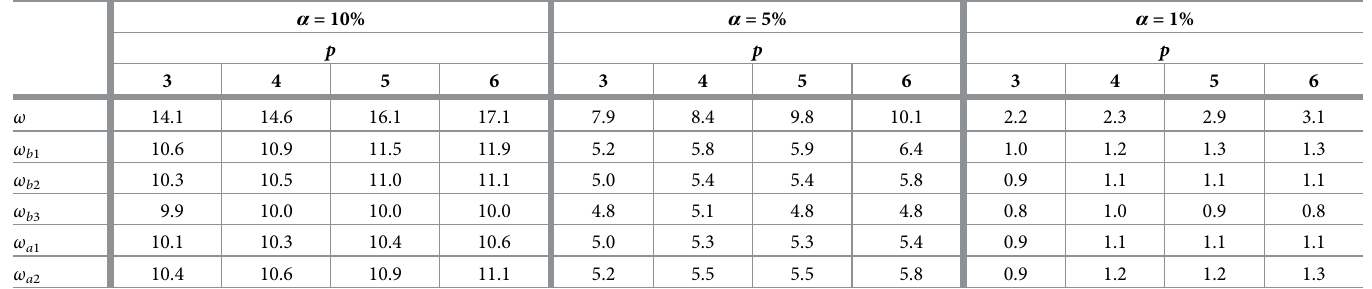
: b ¼ 0 , varying number of nuisance parameters. 0 2